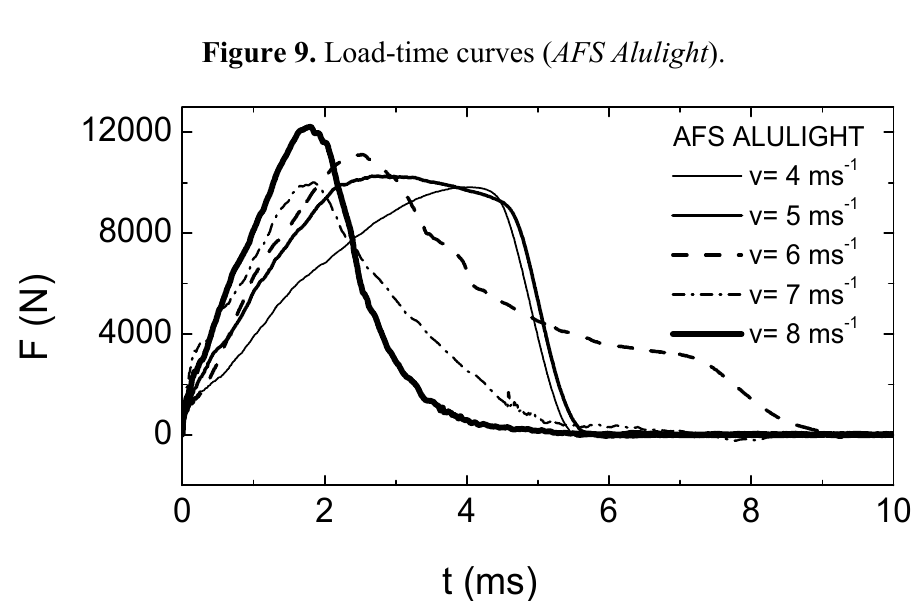
Figure 9. Load-time curves ( AFS Alulight